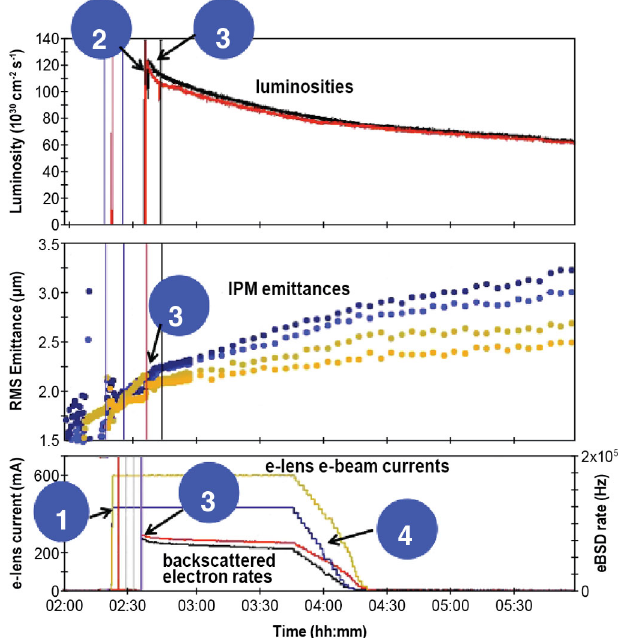
FIG. 4. Operational use of the electron lenses in 2015. The top plot shows the luminosities of both experiments, the middle plot the rms emittances as measured by the IPMs, and the bottom plot the electron beam current of both lenses (left scale) as well as the signal from the backscattered electrons (eBSD, right scale). The numbers “ 1 ” through “ 4 ” indicate times for certain events that are explained in the